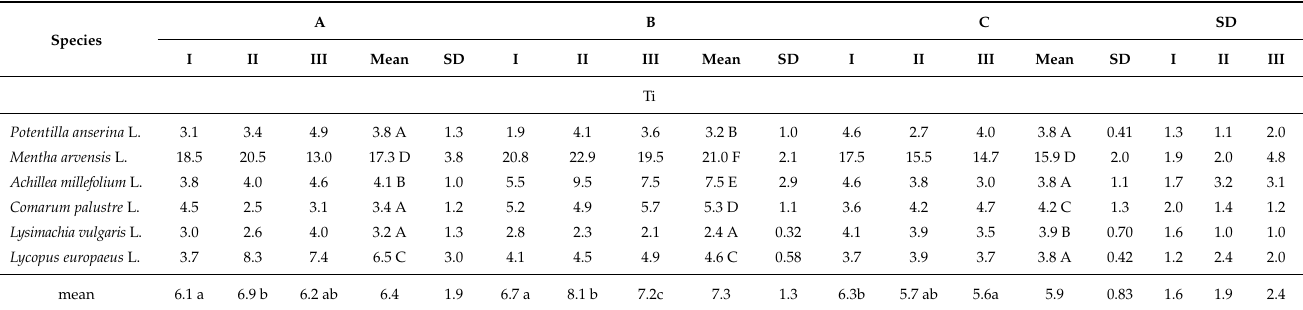
Table 3. Ti concentration (mg kg − 1 ) in the biomass of some